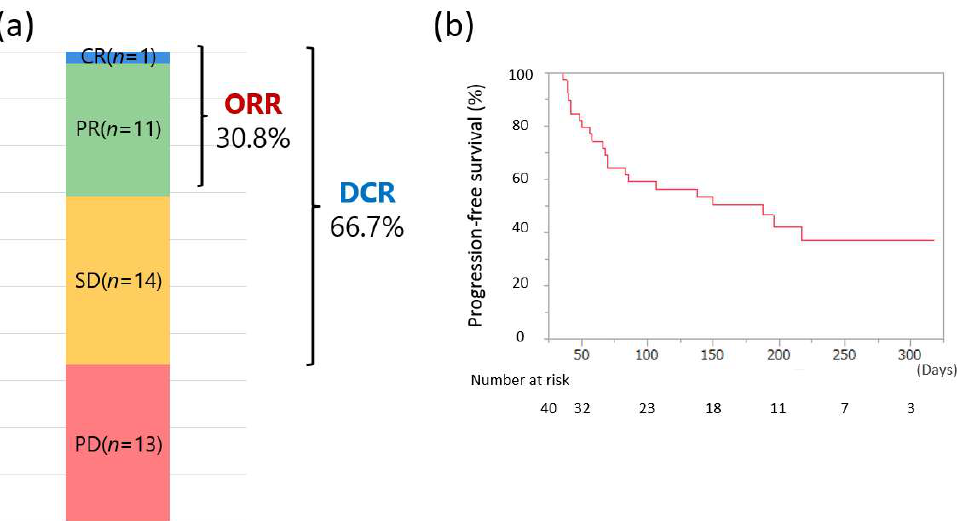
Figure 1. ( a ) Treatment response to atezolizumab + bevacizumab combination therapy (CR, complete response; PR, partial response; SD, stable disease; PD, progressive disease; ORR, objective response rate; DCR, disease control rate). ( b ) Progression-free survival of all 40 patients.